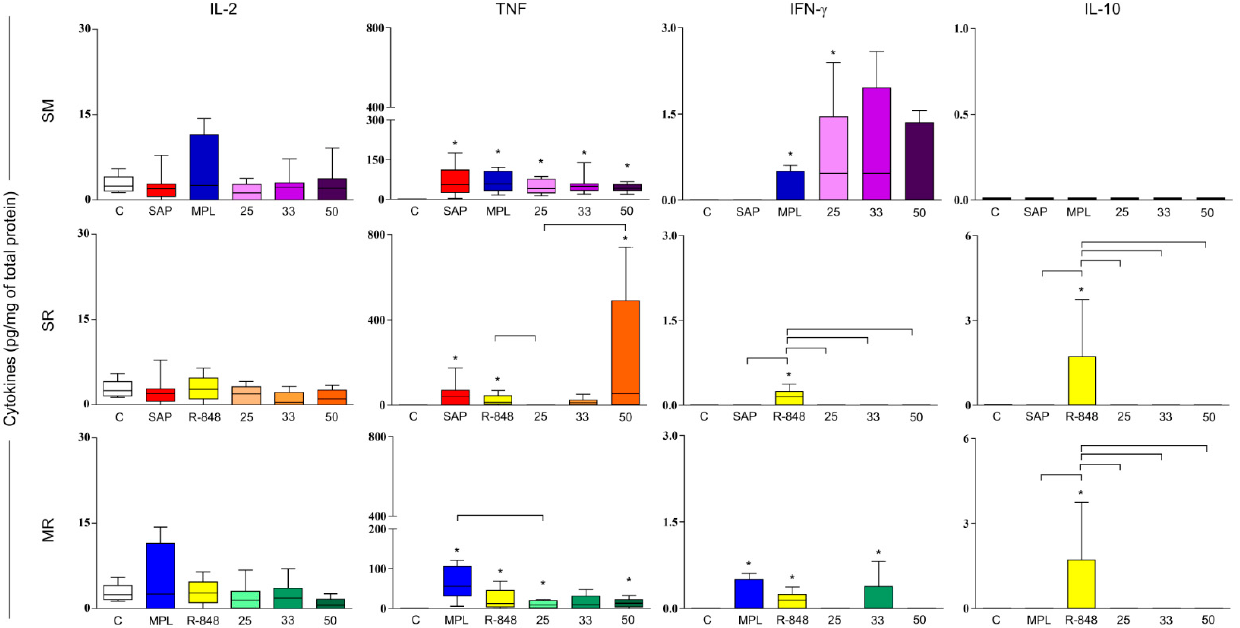
Figure 4. Cytokine measurement (IL-2, TNF, IFN- γ , and IL-10) in the BALB/c mouse skin 48 h after sensitization with the adjuvants isolated or combined into adjuvant systems ( n = 12/group). Cytokine production was expressed by picograms per milliliter (pg/mL) of total protein. The data analyses were performed by Kruskal–Wallis test and expressed as mean/median ± SD. The significant differences are indicated by connector lines for comparison between the groups ( p -value < 0.05) and by (*) for comparison with the control group (C).